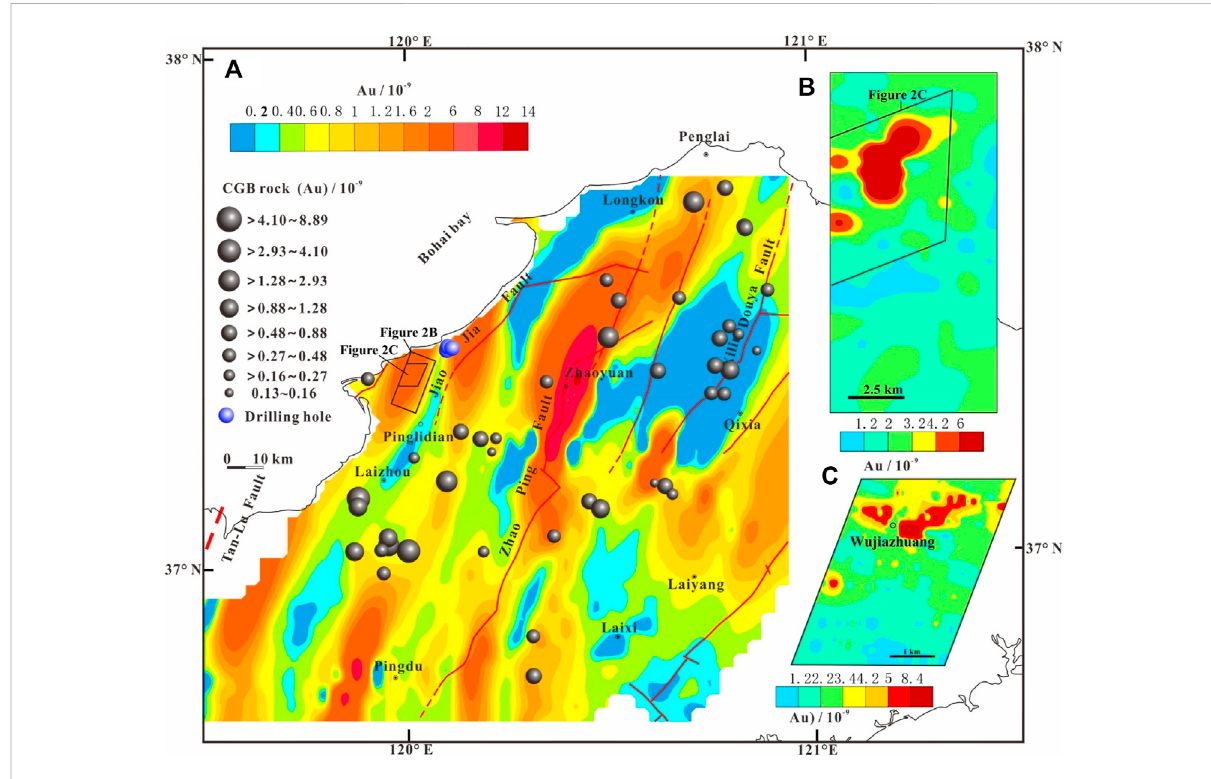
FIGURE 5 Geochemical map of gold by MOMEO and CGB in the Jiaodong gold province (modi fi ed from Wang et al.,